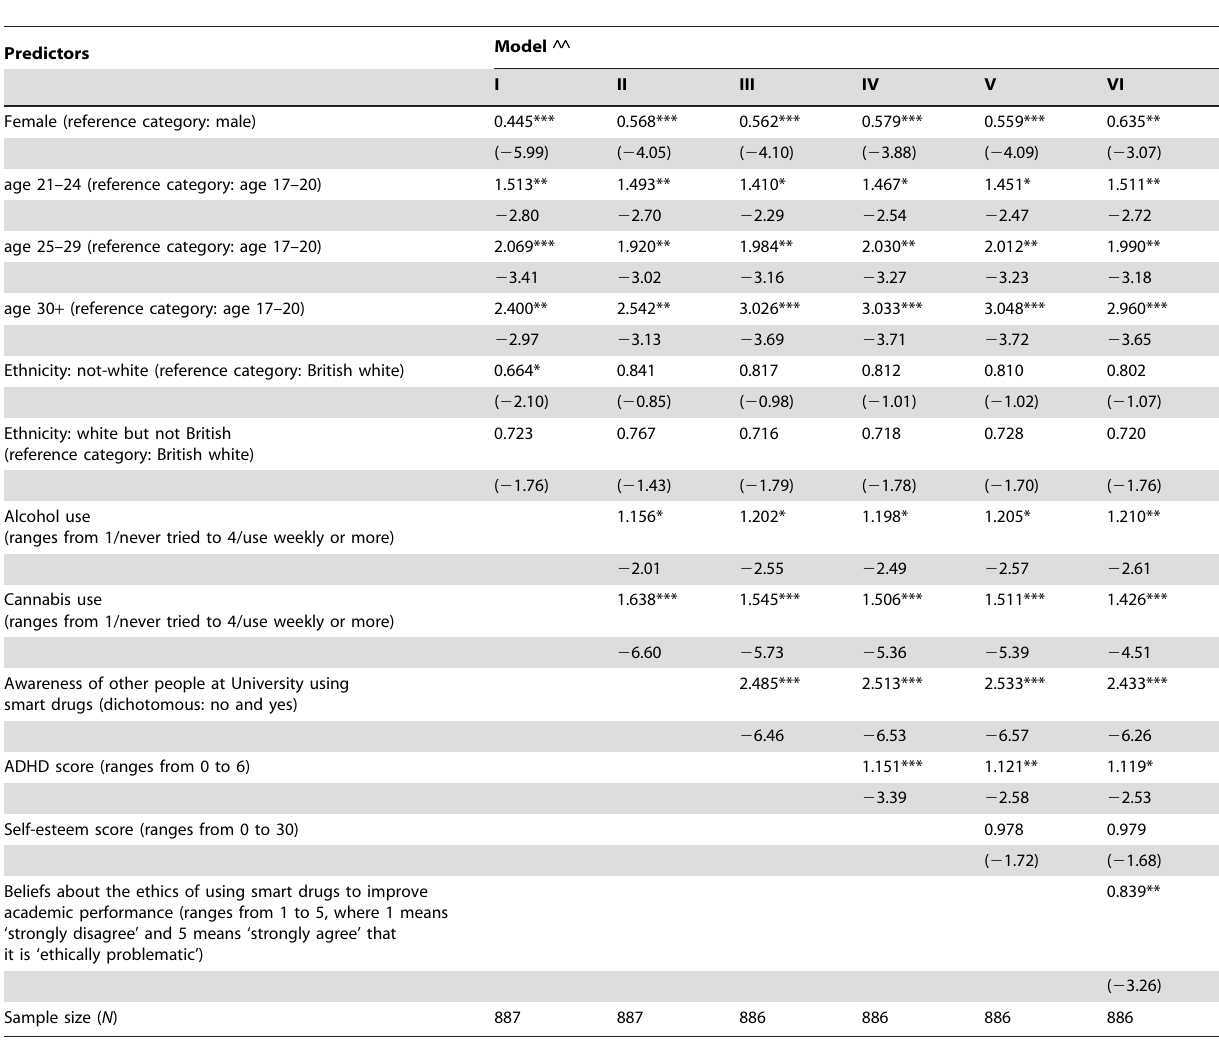
Table 11. Ordinal logistic regression predicting knowledge and use of methylphenidate. +